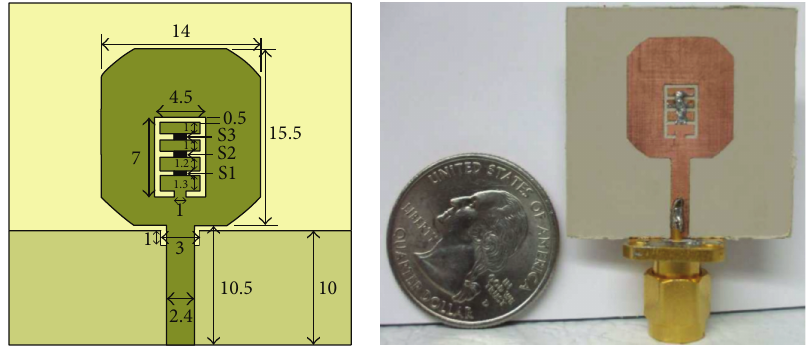
Figure 4: Geometry and photo of an antenna with one reconfigurable rejection band [60].